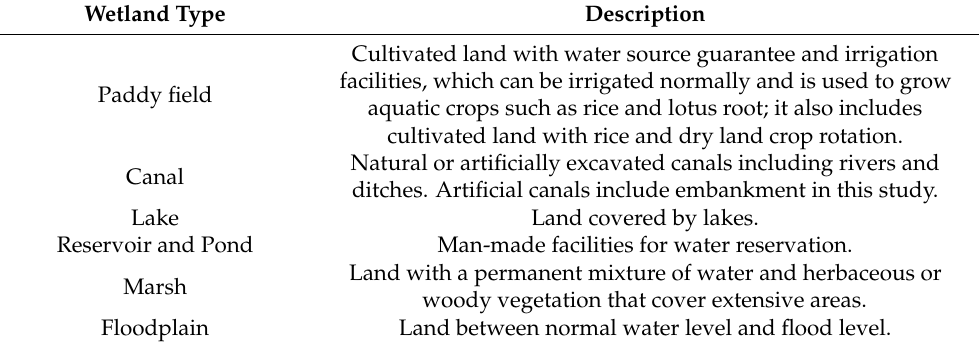
Table 1. Wetland type and description.